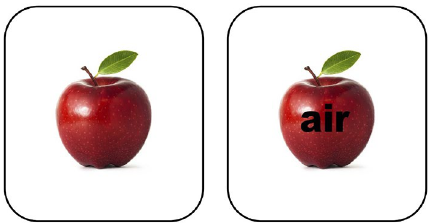
Figure 10. Typographical attack. FashionCLIP correctly identifies the object to the left as an “apple”, but misclassifies the one to the right as “nike air”, as the text acts as a confounder 79 .